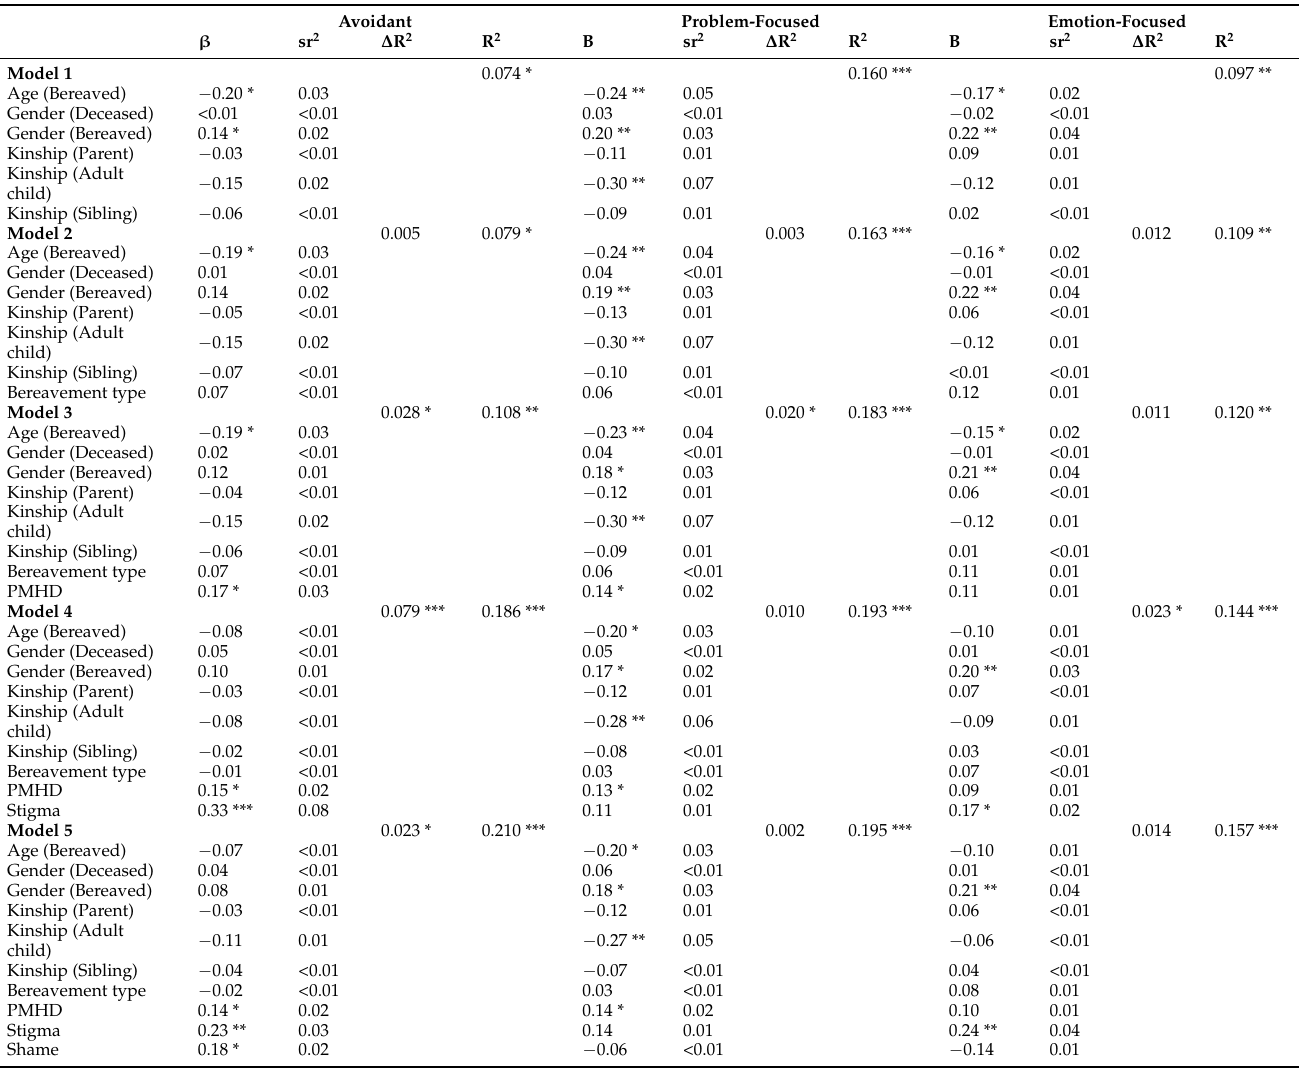
Table 3. Regression models for each coping